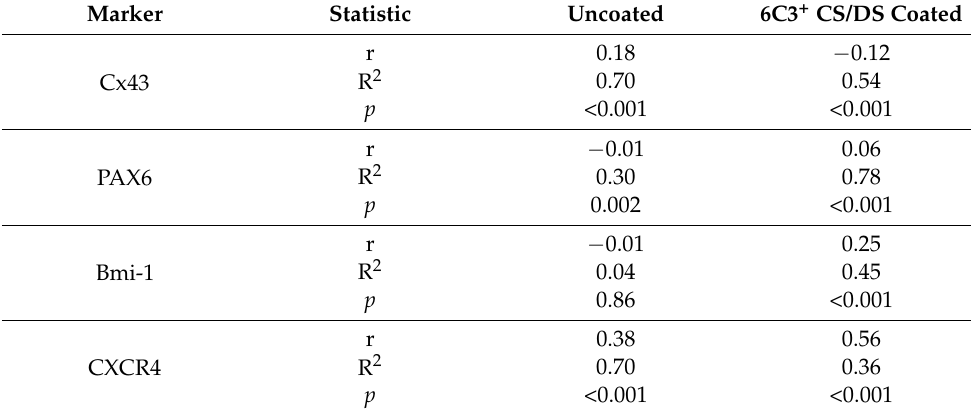
condition and indicative stem cell